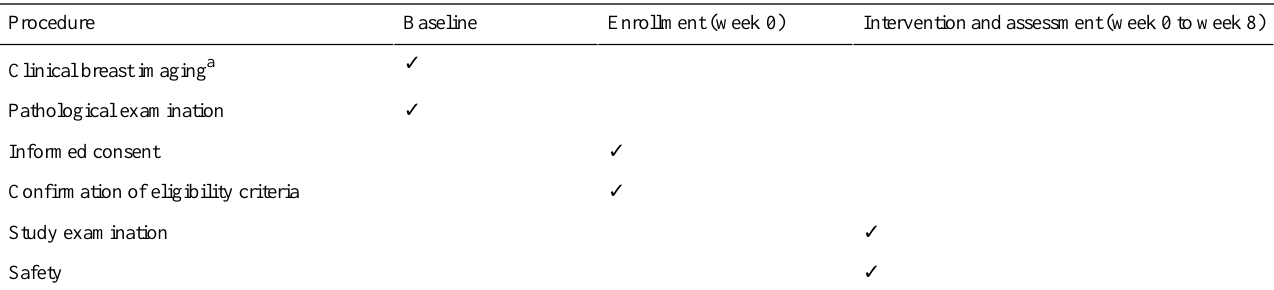
Table 1. Time schedule of the